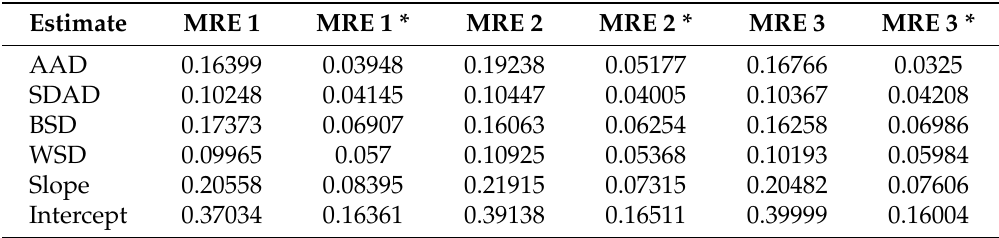
Table 2. Mean relative error for the average of age mixing estimates compared between benchmark data and after calibration with features from HIV epidemiology and sexual behaviour (MRE 1), a phylogenetic tree (MRE 2), and a combination of the two types of features (MRE